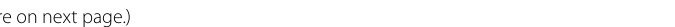
figure on next Fig. 2 Strain/time curves for elastic (spring), viscous (dash in pot), and viscoelastic (spring and dashpot) systems. An applied force (red arrows) generates a stress that results in a yield or strain once the force reaches critical opening pressure. Upper left: the spring models elasticity with a rapid increase in strain leading to a plateau strain, which is distinctive of that spring. Upper right: the dashpot models viscous strain, where movement of the dash progresses (dashed line) with flow of the fluid in the pot around the dash (brown arrows), which is distinctive of the viscosity of the fluid. Bottom: viscoelastic behavior is modeled by the spring and dashpot, where force transfer from the spring to the dash results in a time‑dependent strain with an initial rapid change in strain (1–2 s), which becomes gradual over time (2–5 s). Lung strain follows this behavior (Fig. 3). Bottom left: an extended inspiratory time (HOLD) optimizes lung recruitment once critical opening pressure is reached. Bottom right: a short expiratory time (RELEASE) minimizes lung derecruitment if it is sufficiently fast to prevent reaching the critical collapse